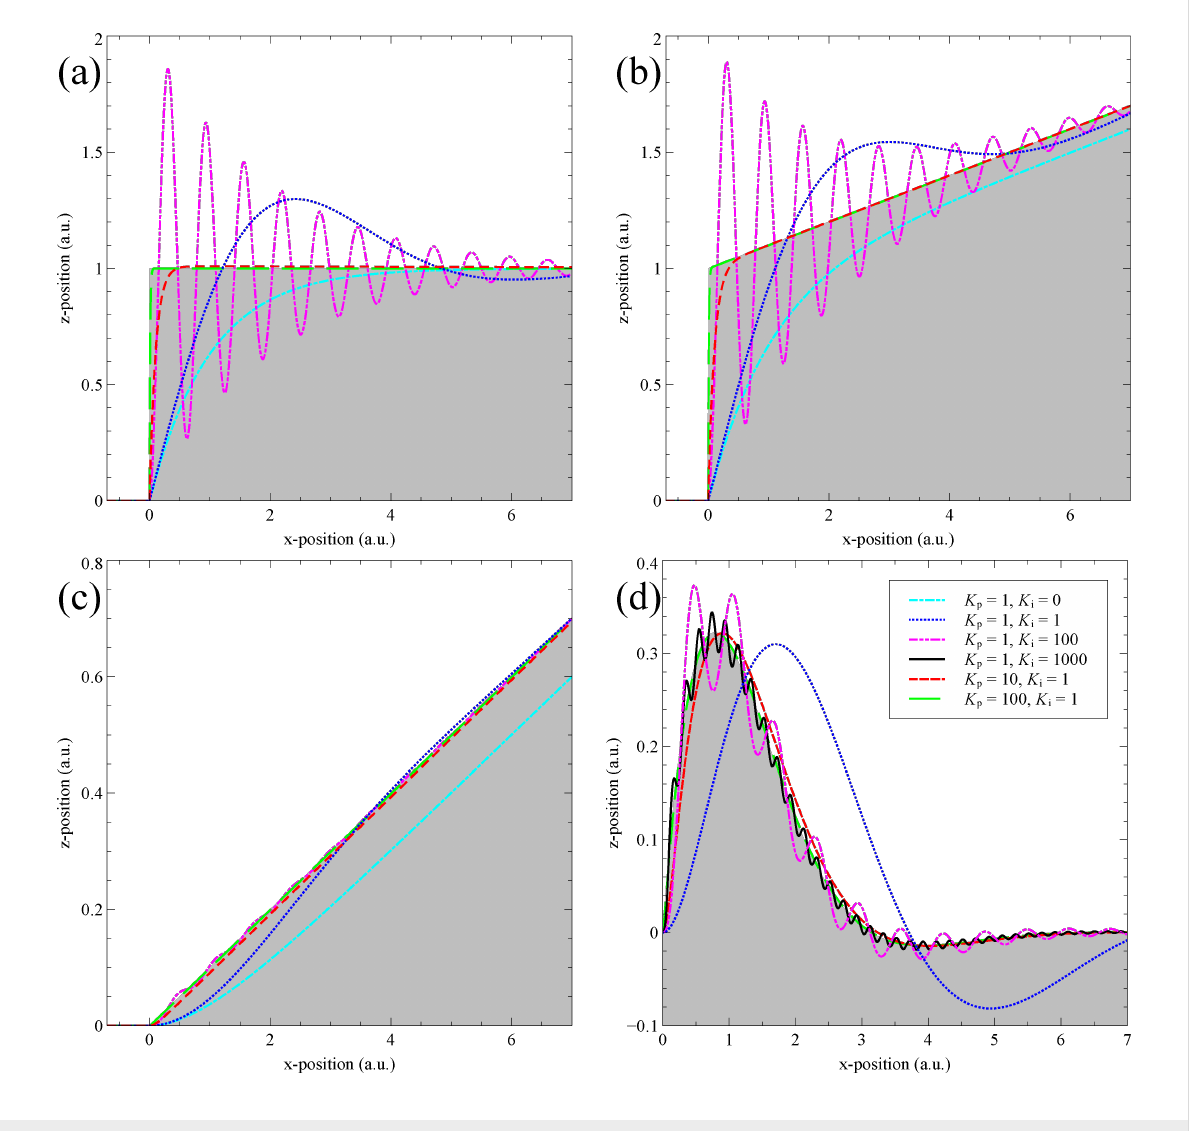
Figure 4: The feedback response of an SPM, without the inclusion of mechanical resonances, calculated for four different topographies, and for a range of feedback gains. Topographies in (a)–(d) correspond to Equation 16–Equation 19 respectively. Not all gains are plotted for all topographies to avoid